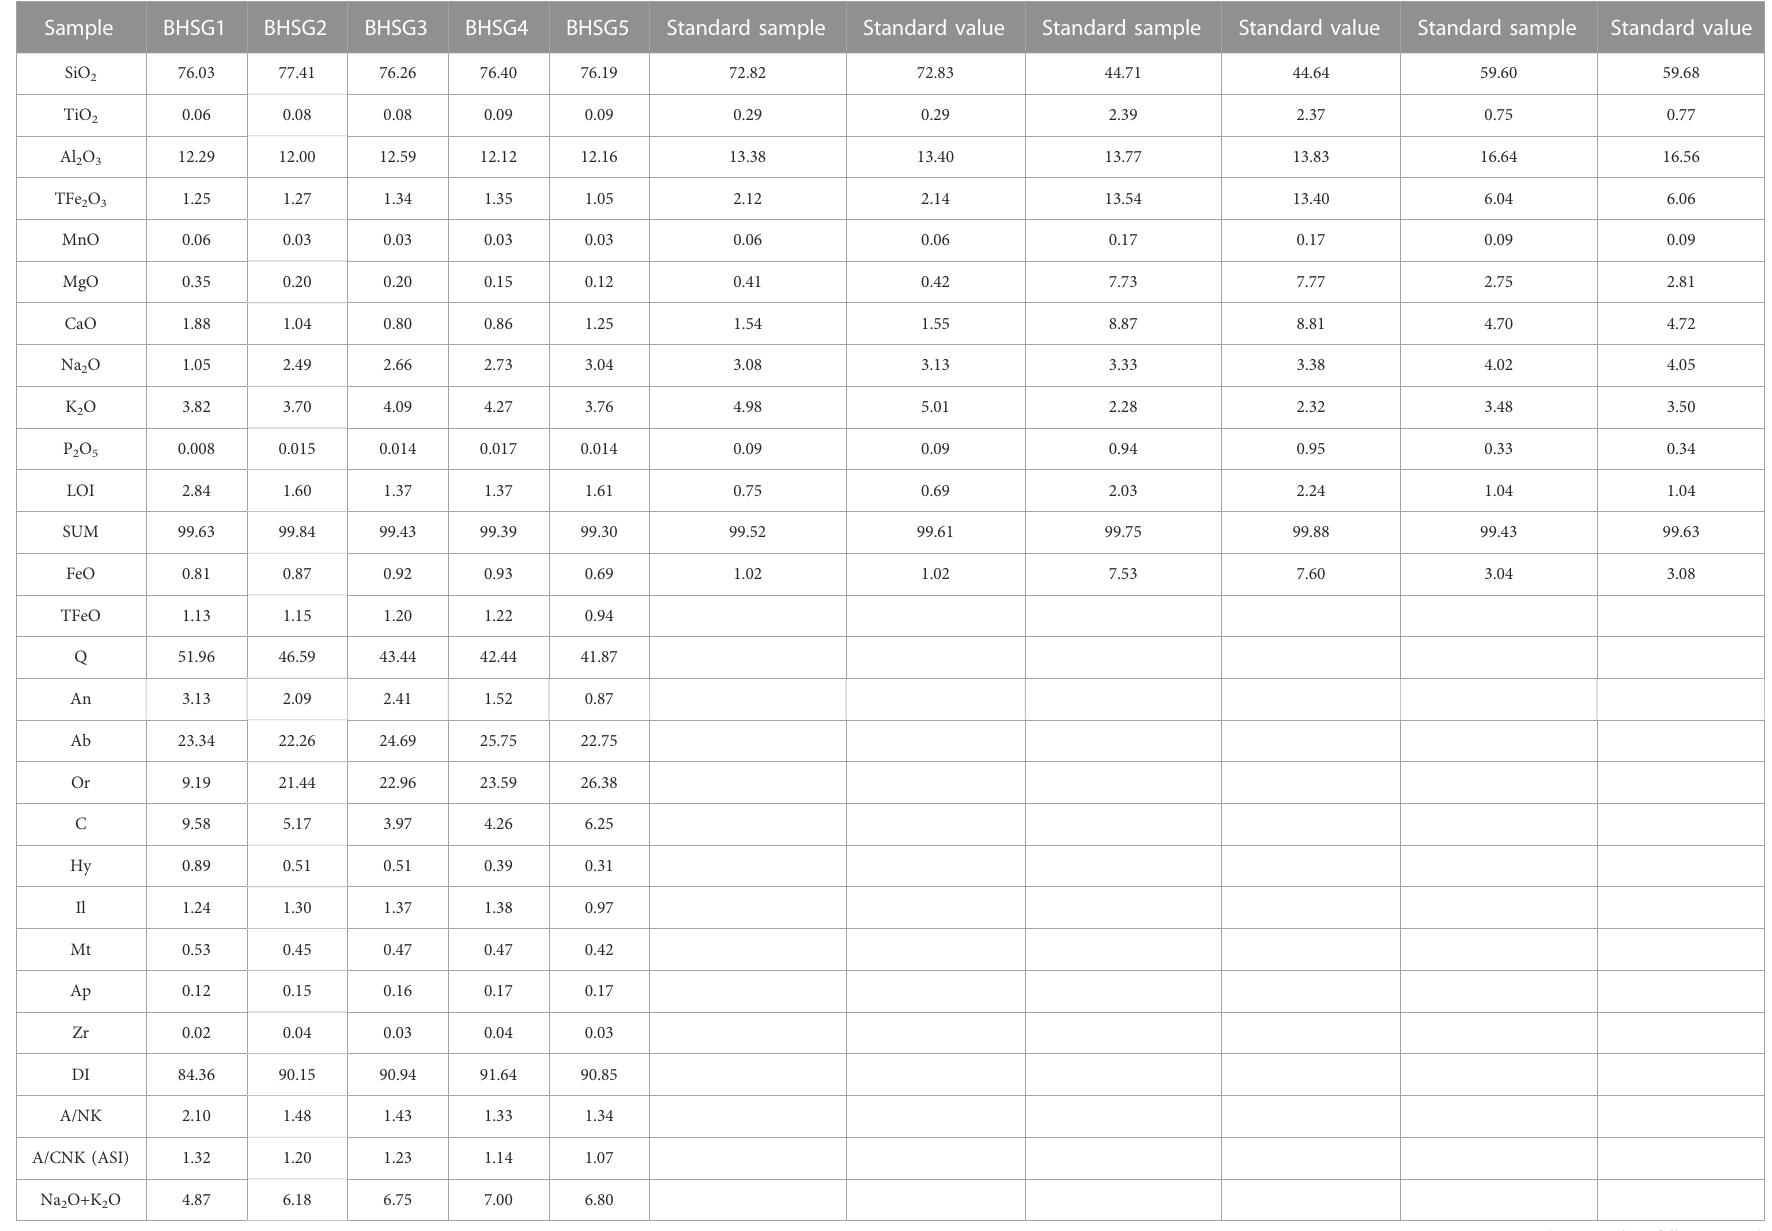
TABLE 5 Whole-rock major-element composition of BHSG and standard